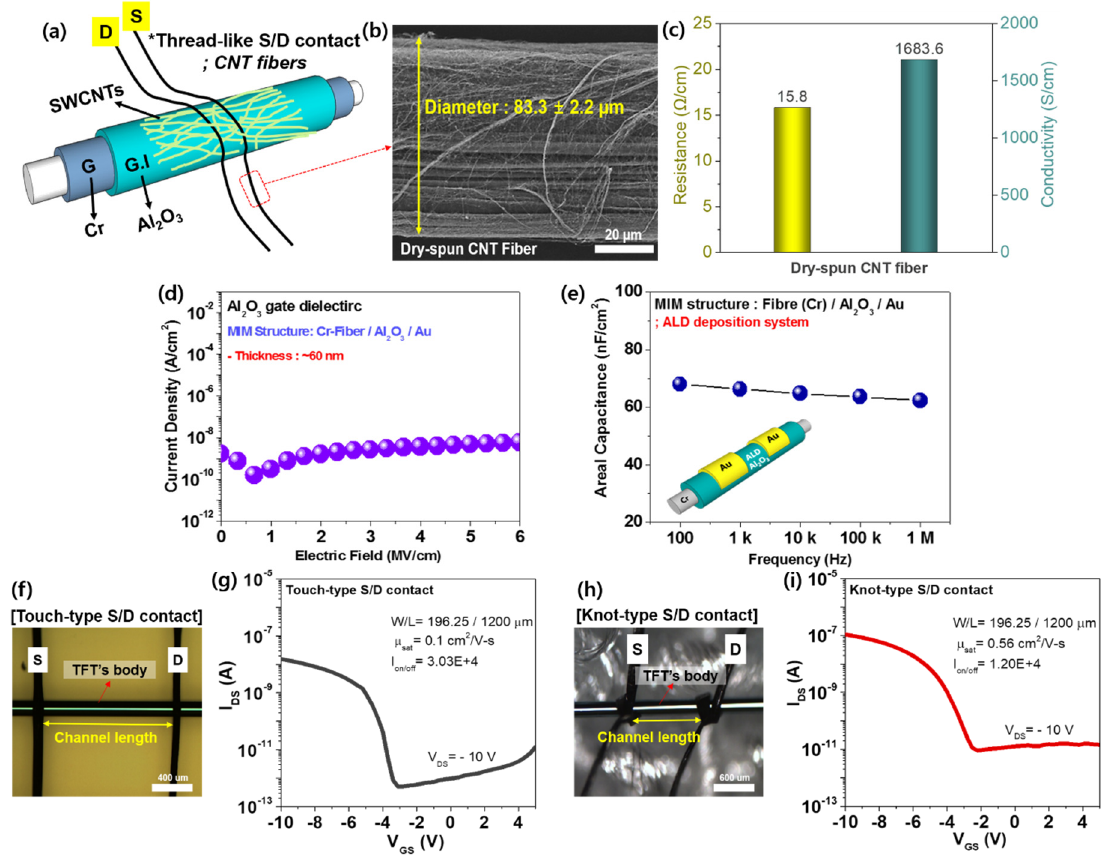
Figure 1. ( a ) A schematic of an ultra-sensitive fiber transistor-type pressure sensor (FTPS) with thread-like carbon nanotube (CNT) fiber S / D electrodes. ( b ) A field-emission scanning electron microscopy (FESEM) image and ( c ) the electrical conductivity / resistance of the dry-spun CNT fiber. The electrical characteristics of atomic layer deposition (ALD)-deposited Al 2 O 3 gate dielectric on a 1-D fiber substrate; ( d ) the leakage current density versus electric-field (J-E) and ( e ) the areal capacitance versus frequency (C-F) curves. The optical images that show the channel length (1200 µ m) and the thin-film transistor’s (TFT’s) body consisting of three components such as gate, gate dielectric, and channel layers, and the transfer characteristics of the FTPS with ( f , g ) the touch-type S / D contact and ( h , i ) the knot-type S / D contact.